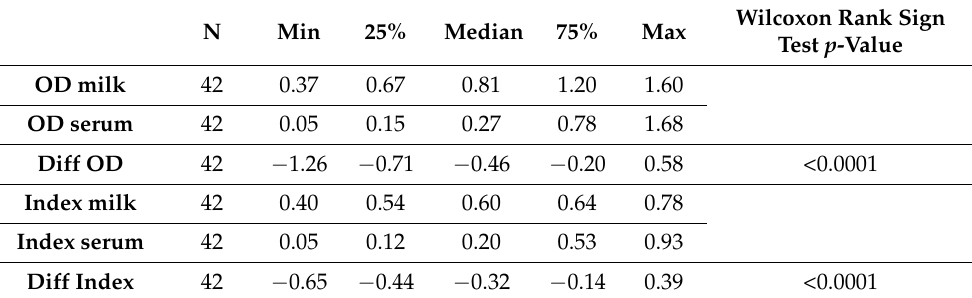
Figure 1. IgG antibodies in the observation period: 20 days to 4 months after the second dose of vaccine, in breast milk and serum. Data were obtained by the HBelisa SARS-CoV-2 neutralizing antibody detection kit (HB Healthcare corp.). If the index is < 0.8 , the sample is positive for neutralizing antibodies to SARS-CoV-2. Each sample was tested twice. Data are presented as index value ± standard deviation. Table 2. Comparison of antibody level in serum and milk (Wilcoxon